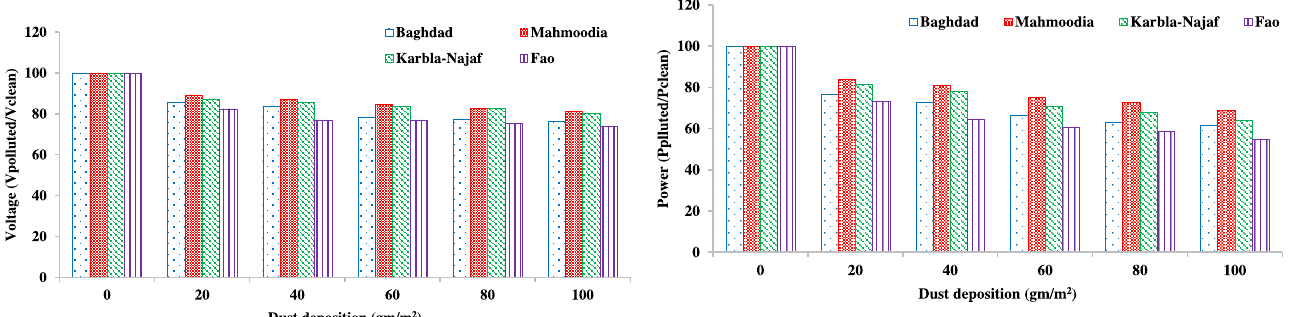
Fig. 5. Dust accumulation effect on V polluted / V clean ratio.